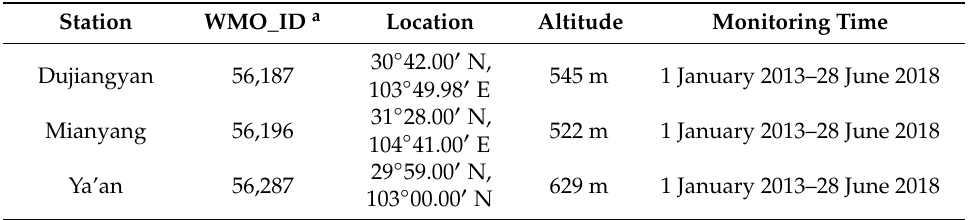
Table 1. Periods during which rainfall data were collected from the website https: // rp5.ru.